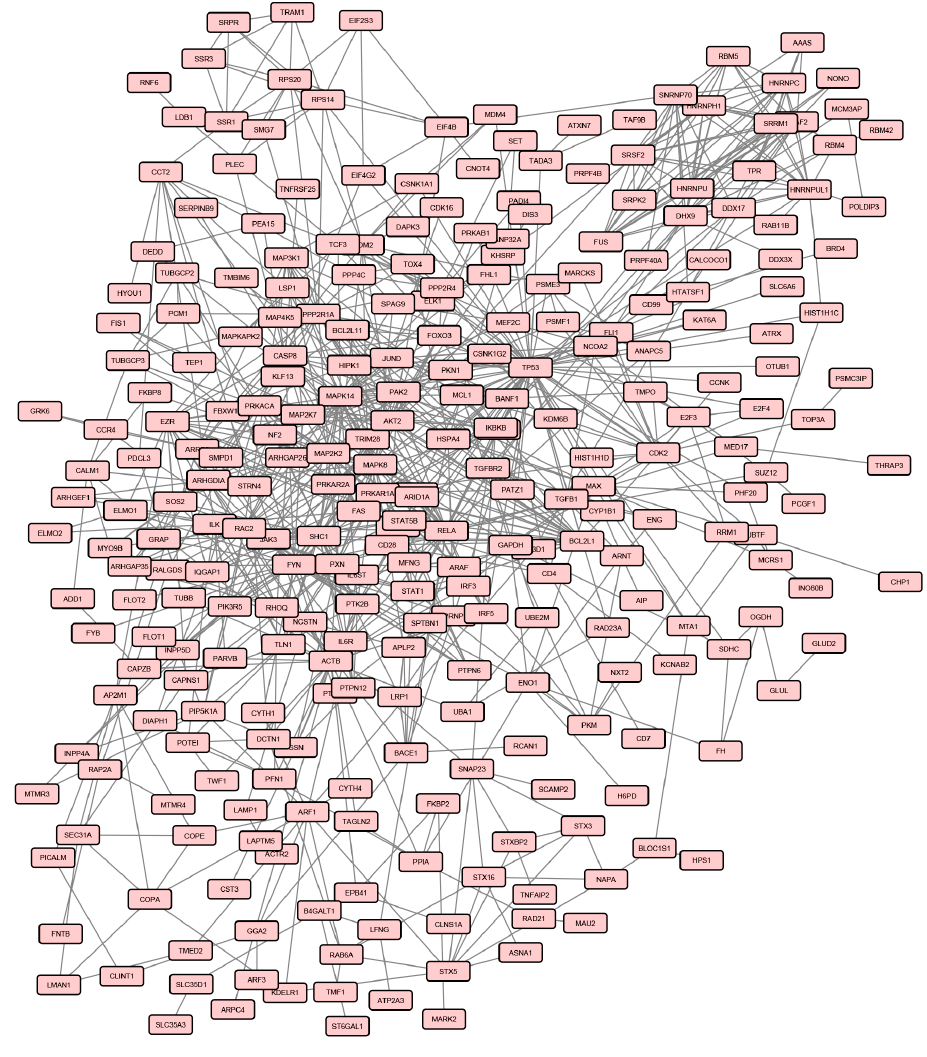
Figure 3. Protein-protein interaction (PPI) network of DEGs in AS patients after treatment.